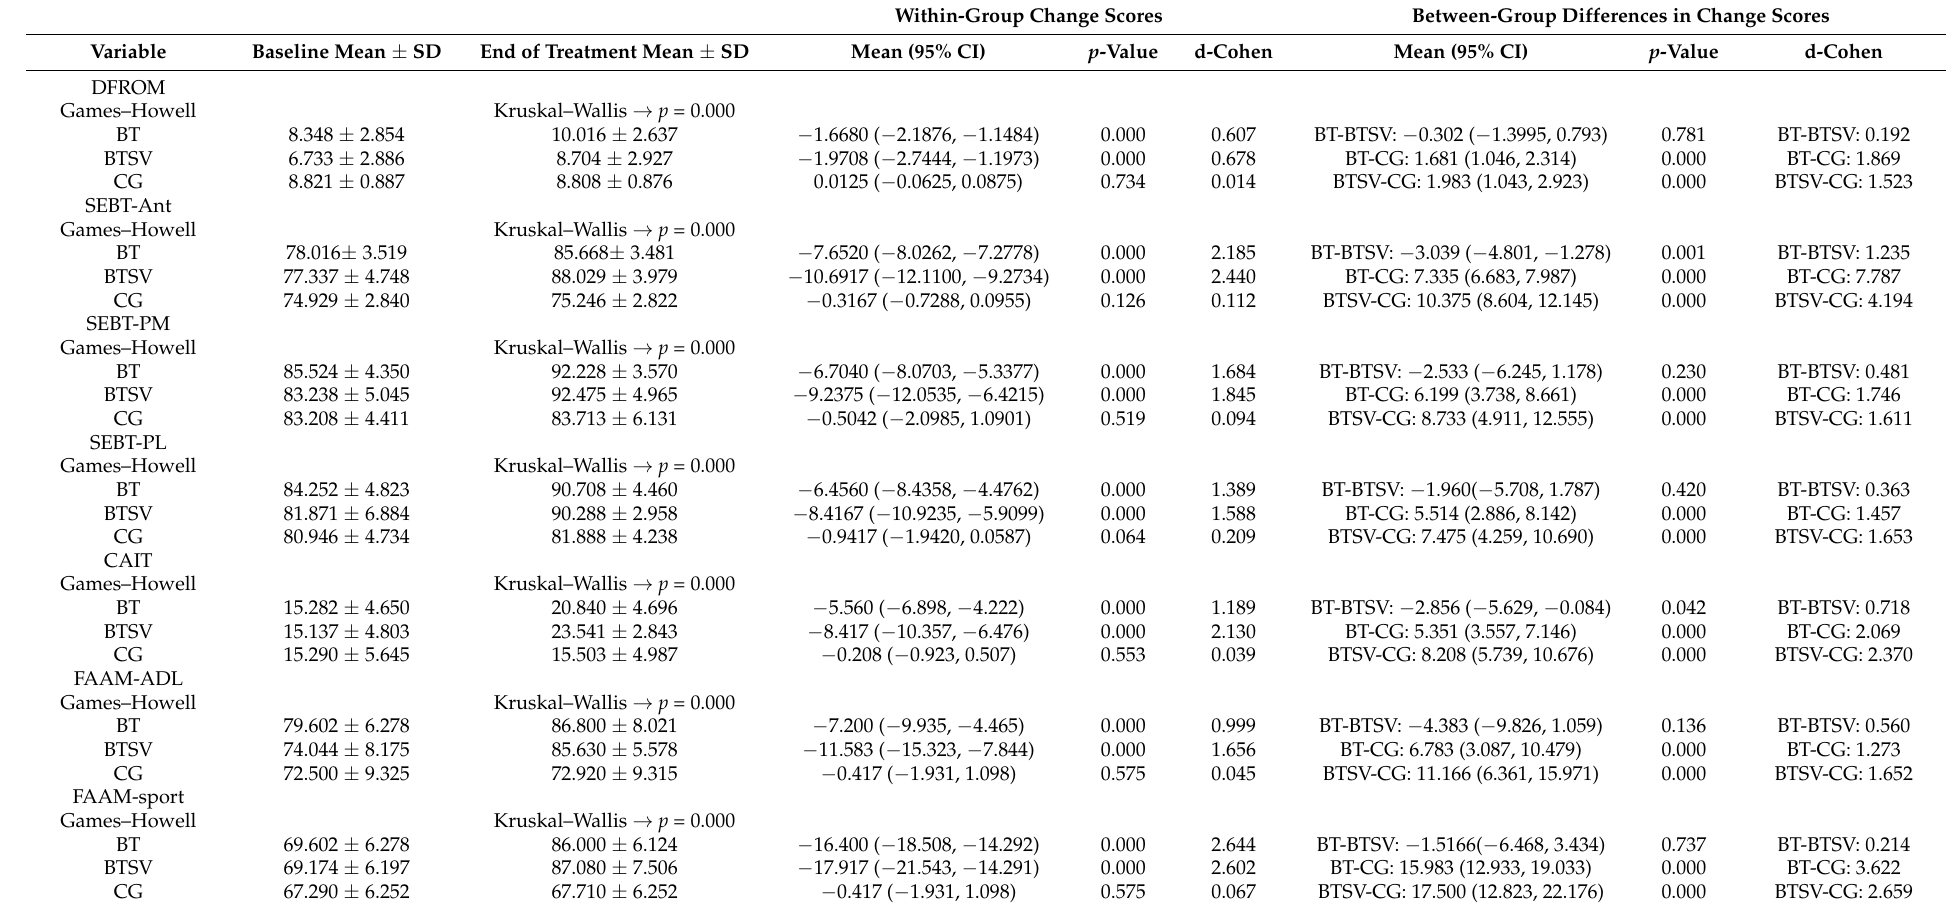
Table 3. Within-group and between-group change